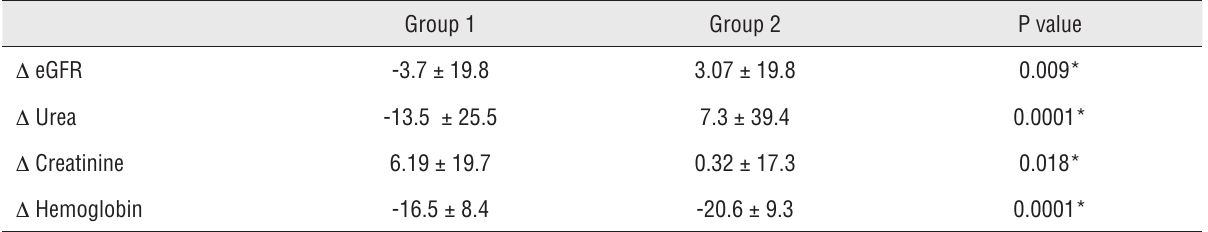
Table 2 - The percentage changes of Urea, creatinine, eGFR before and after surgery.